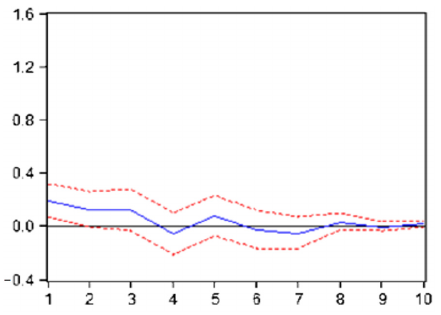
Figure 4. Impulse response of Shanghai copper to London copper yield.